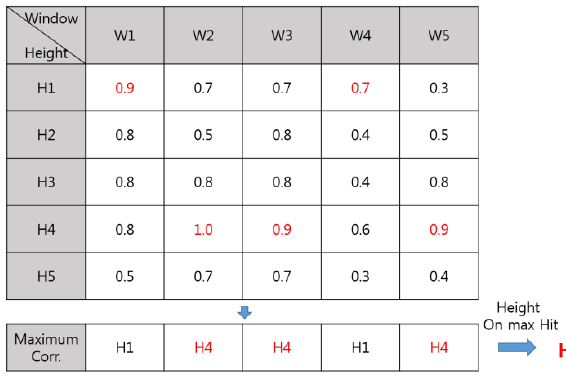
Figure 5. Concept of matching in the object space. (a) Mismatched point, (b) Matched point